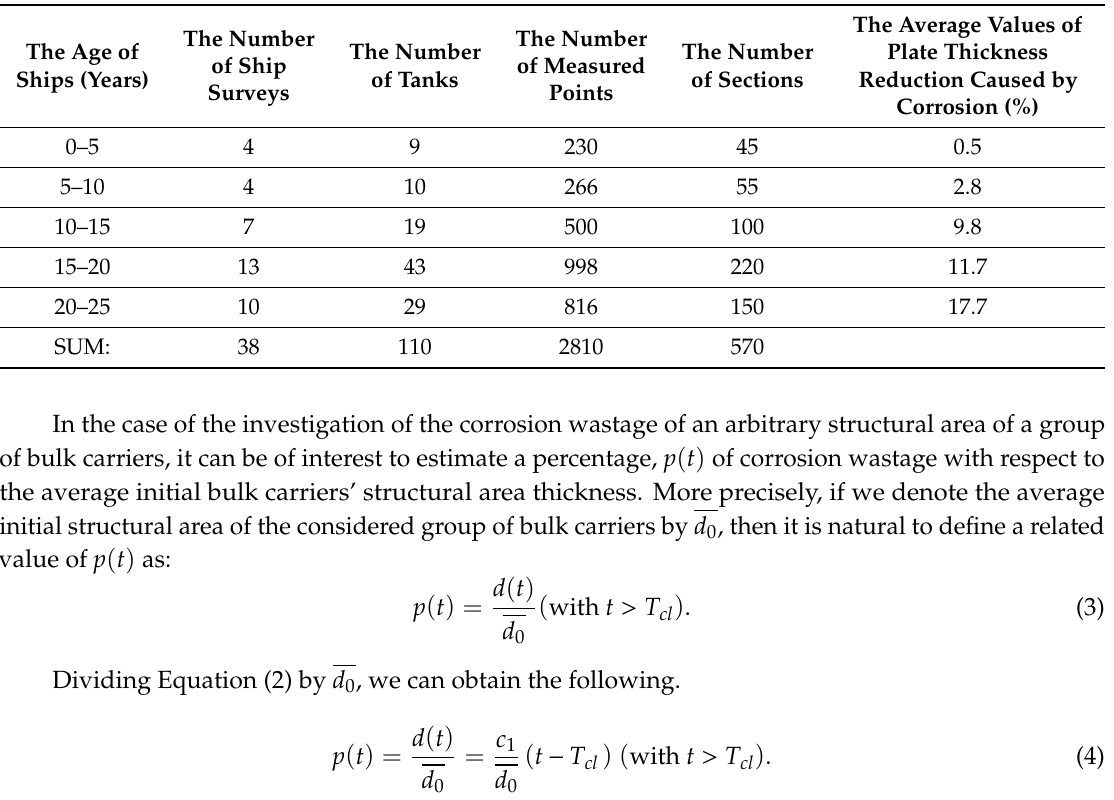
Table 1. A database of the percentage of thickness reduction of inner bottom